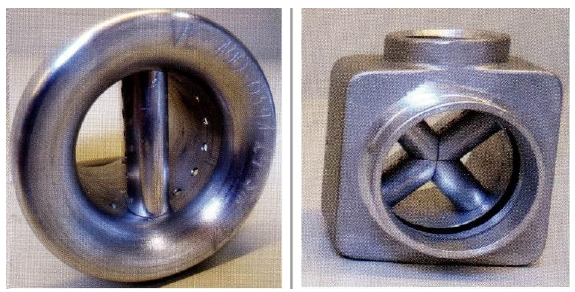
Fig. 20.The examples of throat constructions from gas mixers for different engines (reproduced from [10])